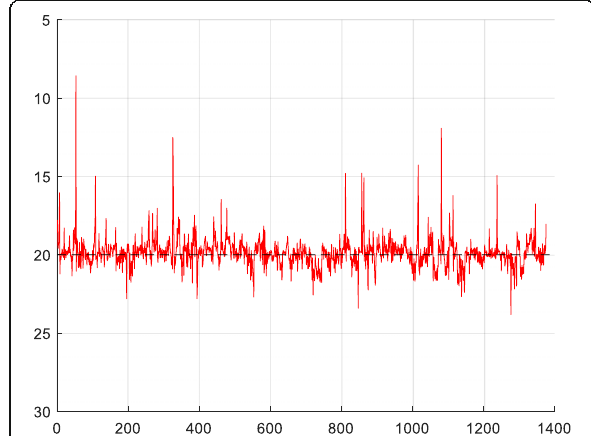
Fig. 10 The red curve is the distance between the inner lower lips position determined by the ground truth and the outer lower lips position obtained by the HD-CTM. Some evident errors come from our detection